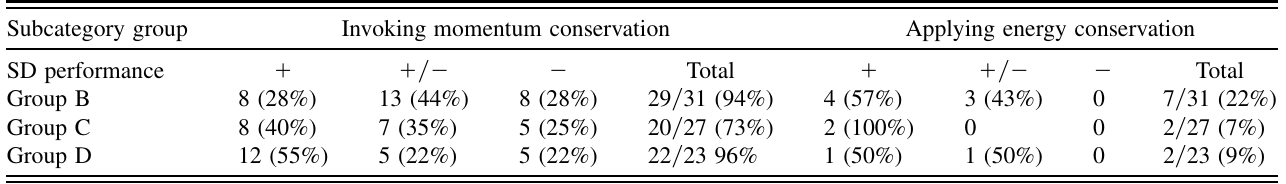
TABLE VII. Analysis of self-diagnosis subcategories. ‘‘ þ ’’ represents a correct diagnosis, ‘‘ þ = (cid:2) ’’ represents a partially correct diagnosis, and ‘‘ (cid:2) ’’ represents an incorrect diagnosis or no diagnosis performed. ‘‘Total’’ refers to the total percentages of students who made mistakes in either subcategory. The students who got a subcategory correct are not included. SD refers to the student’s self-